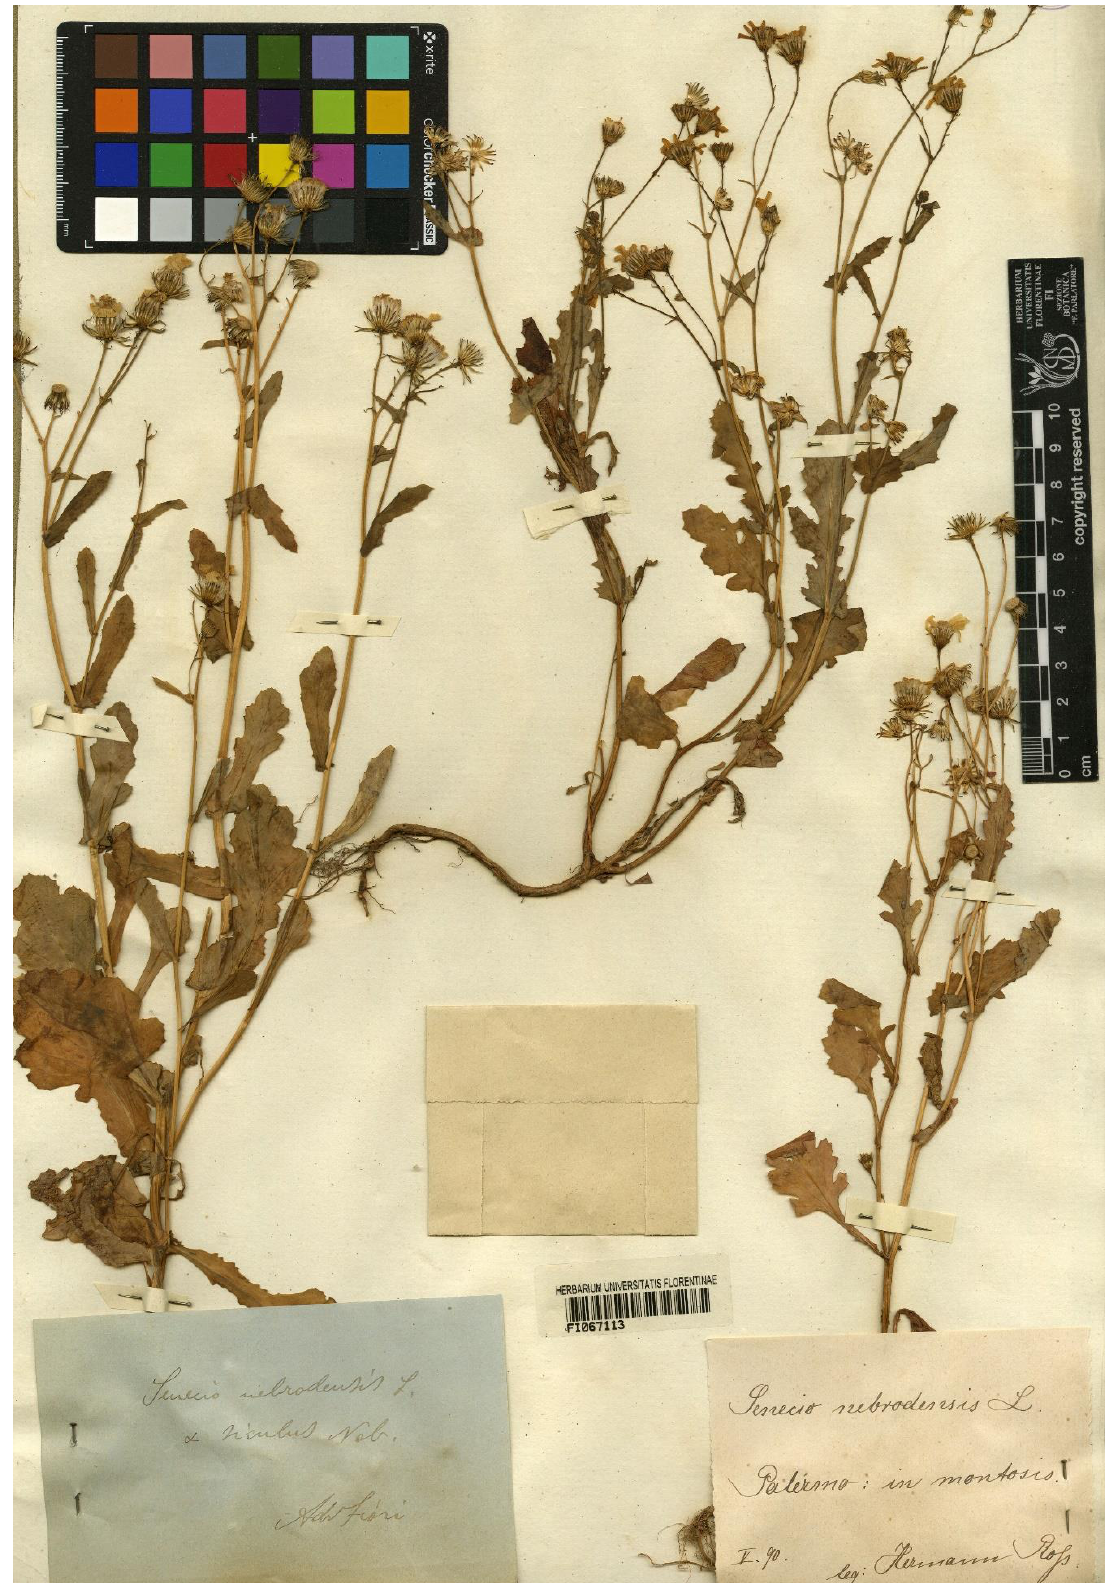
Figure 4. The specimen FI067113 collected by Hermann Ross and revised by Adriano Fiori, here designated as lectotype of the name Senecio nebrodensis var. siculus Fiori (photo reproduced with permission).